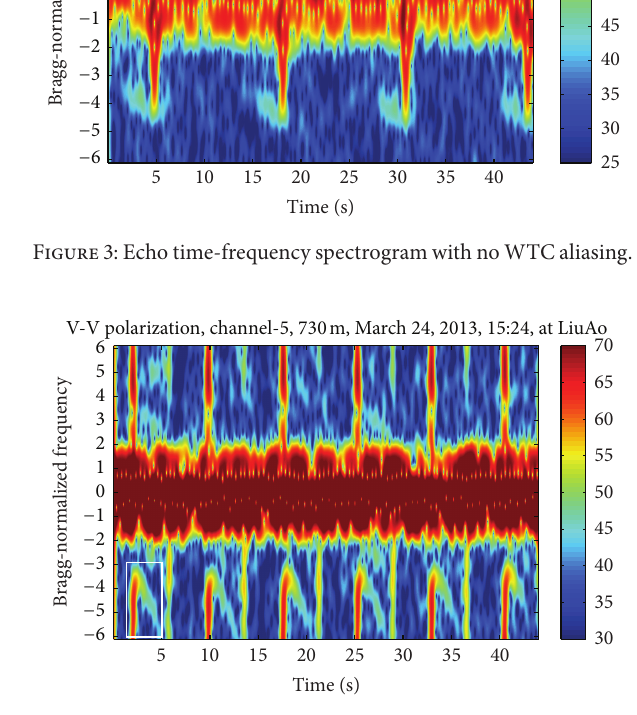
Figure 4: Echo time-frequency spectrogram with WTC